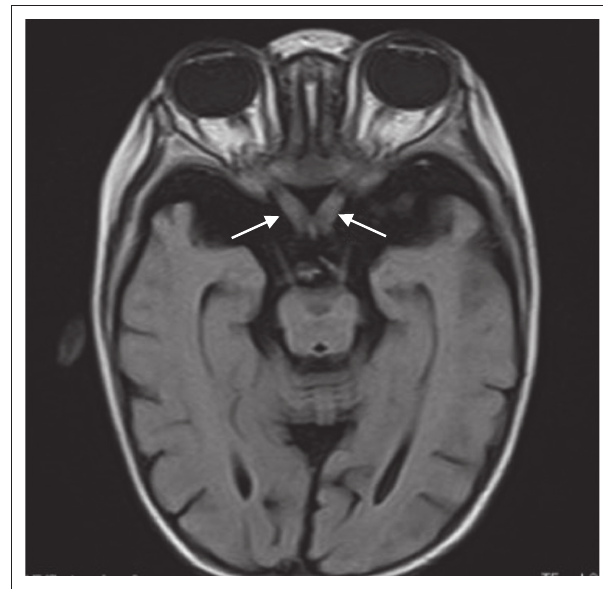
FIGURE 4: T2 FLAIR axial image of patient 2. Enlargement of the pre-chiasmatic optic nerves bilaterally